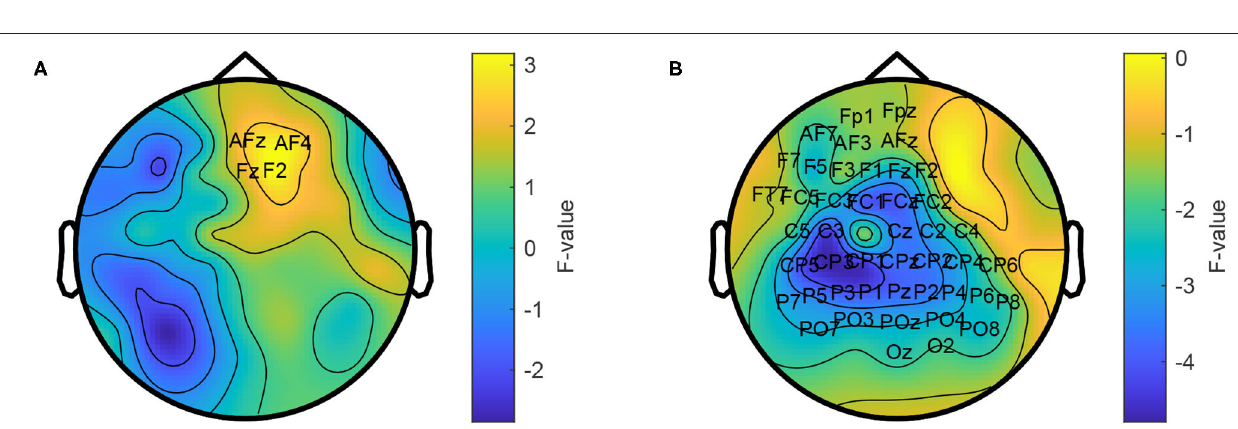
FIGURE 2 | Correlation between the ratings given by each participant (3 boxes on the left) and between the partners in a dyad (next 3 boxes). The box on the right shows the distribution of correlations between the self-assessed performance (R1) and the time-accumulated distance between the ball and the target (d). Red lines show the median, blue boxes the 25 and 75% quantiles, whiskers the most extreme values not considered outliers, and red crosses show outliers. Medians are different at the 5% level if the notches do not overlap.